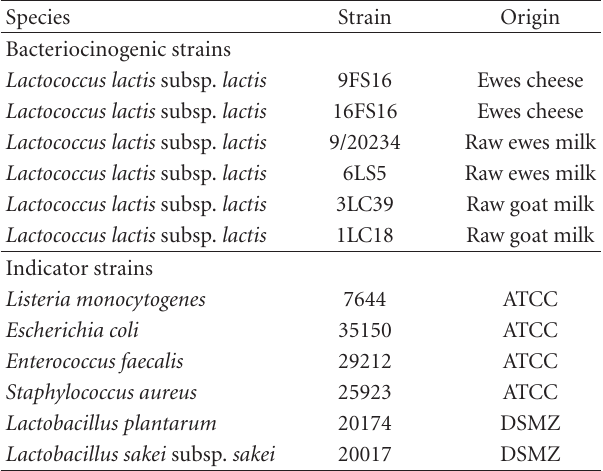
Table 1: Bacteriocinogenic strains of Lactococcus lactis subsp. lactis and indicator bacteria used in this